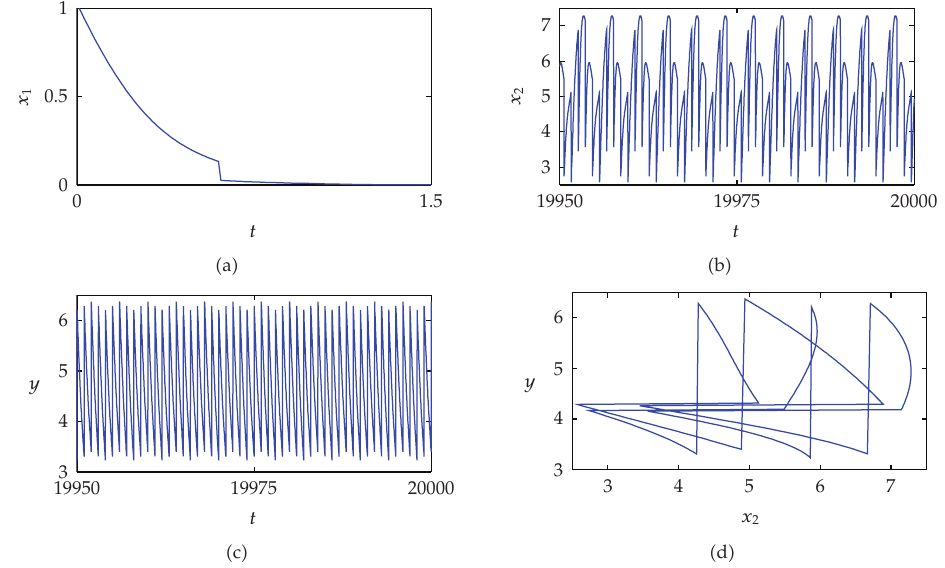
Figure 4: (cid:3) a (cid:4) – (cid:3) c (cid:4) Time series. (cid:3) d (cid:4) The trajectory of system (cid:3) 1.2 (cid:4) with an initial value (cid:3) 2 , 3 , 1 (cid:4)